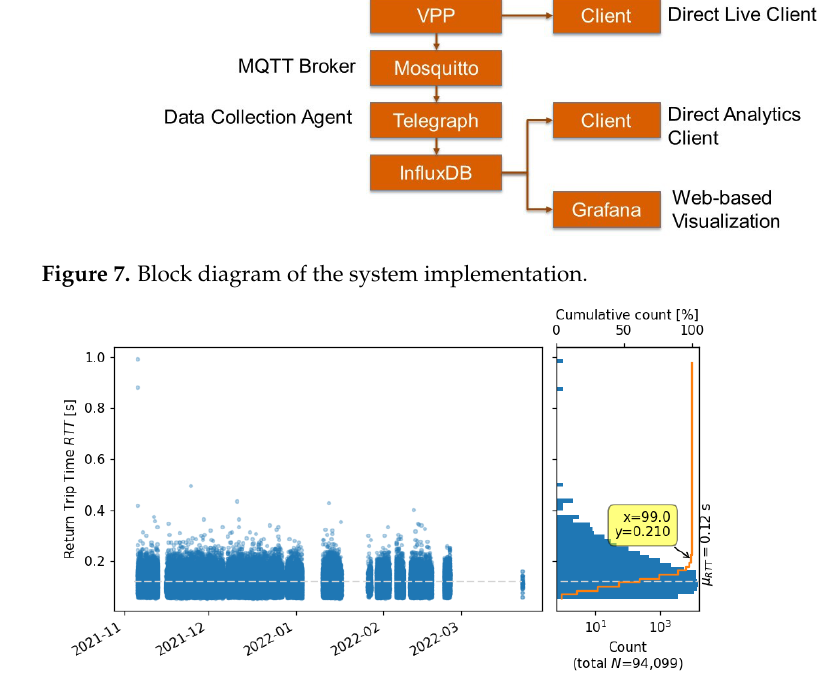
Figure 8. RTT for a direct inverter